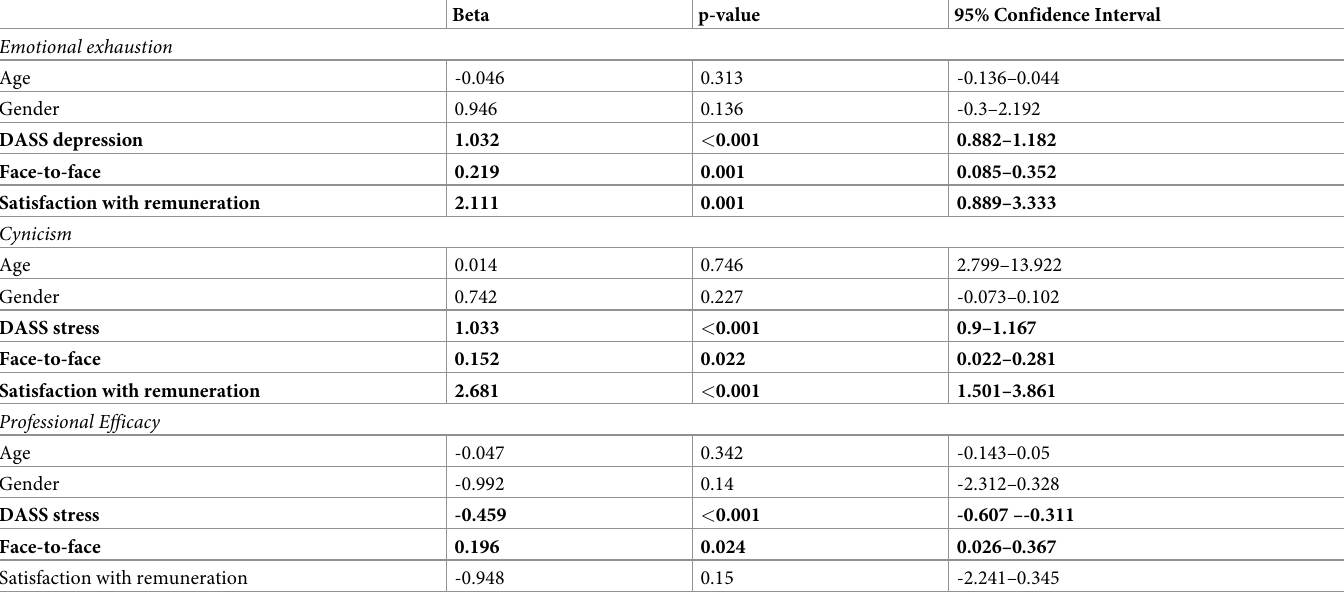
Table 3. Linear regression models with emotional exhaustion, cynicism and personal efficacy as the dependent